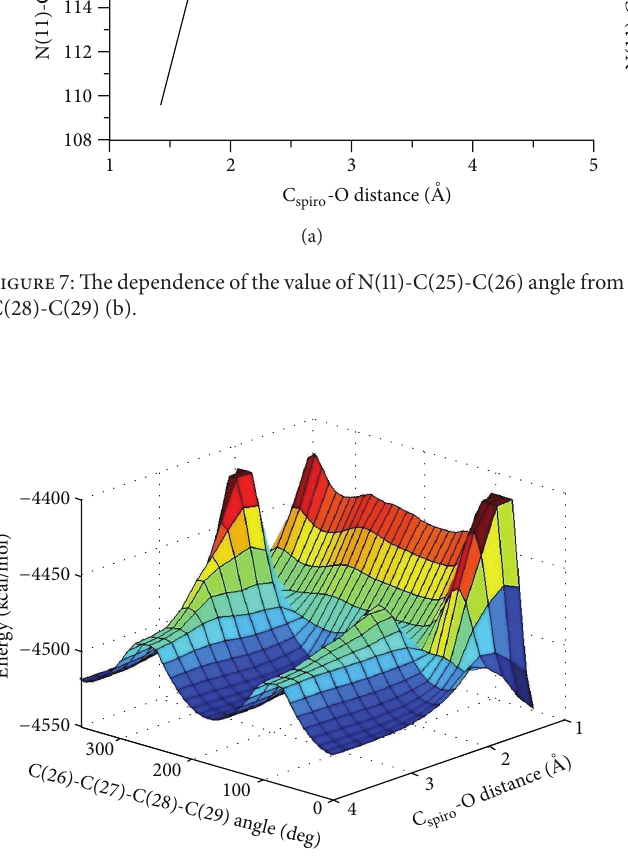
Figure 8: The 3D diagram of the potential surface of the spiropyran.